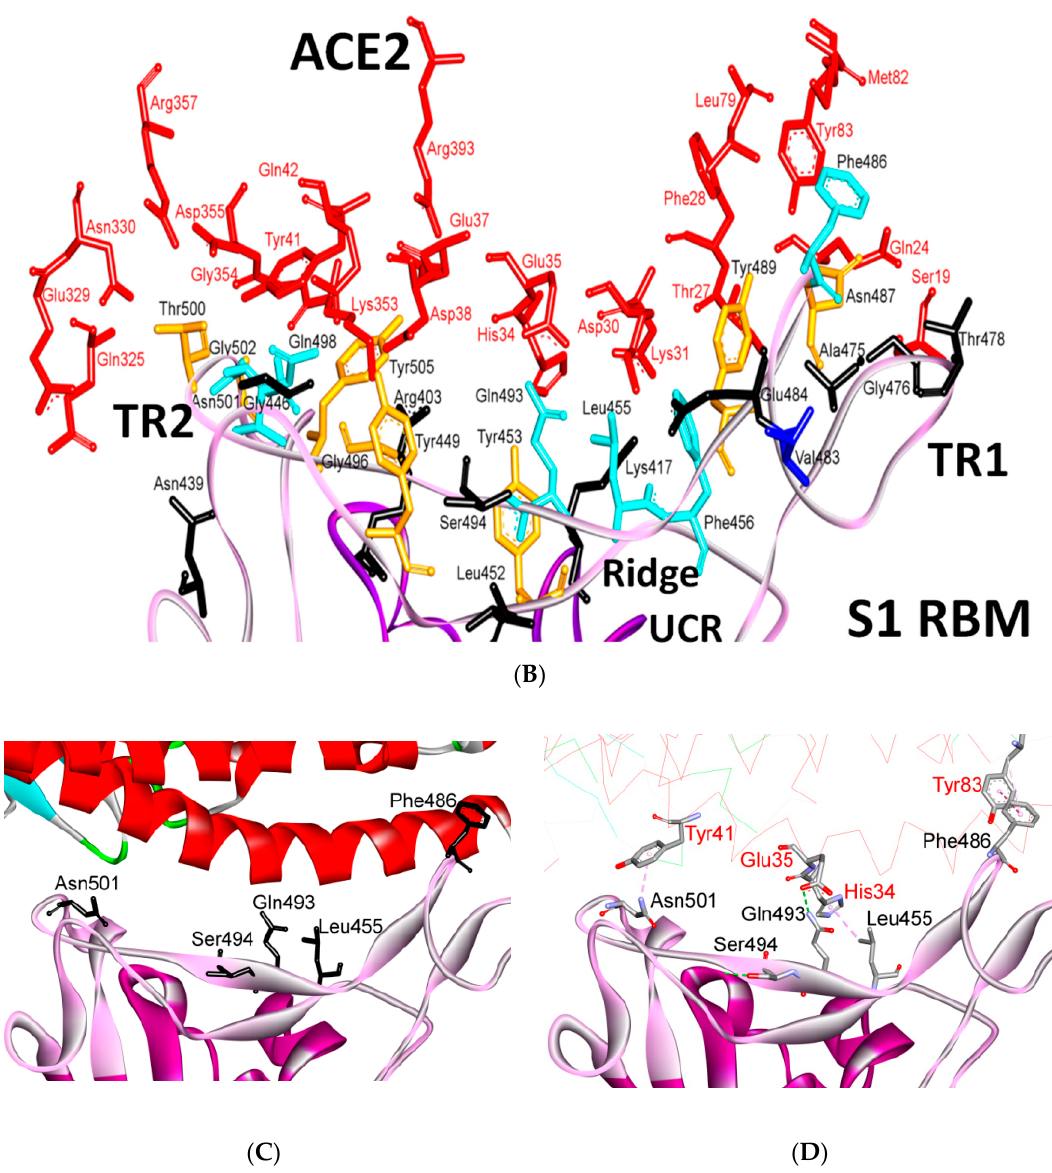
Figure 11. Binding interface and interactions between RBM of SARS-CoV and SARS-CoV-2 with ACE2. ( A , B ) interacting residues between the RBM and ACE2 for SARS-CoV and SARS-CoV-2, respectively. Red, orange, cyan and black colors indicate the interacting amino acids from ACE2, identical residues between SARS-CoV and SARS-CoV-2, di ff erent residues with partially conserved contacts, and di ff erent residues with di ff erent contacts, respectively. Ridge: region between TR1 and TR2. UCR: Upper core region. A Leu to Phe486 mutation (in addition to Pro to Ala475, Pro to Glu484, Lys to Thr478, Asp to Gly476 mutations and a Val483 insertion) in TR1 increases its hydrophobicity and the order of its structure, while mutations in the ridge region of Val to Lys417 (which makes electrostatic interactions), Asn to Gln493 (more hydrogen bonding), Asp to Ser494 and Lys to Leu452 (which increase the hydrophobicity of the shallow pit) give SARS-CoV-2 an advantage to bind mainly through these regions. Arg426, Thr433 and Tyr484 in SARS-CoV (instead of Asn439, Gly446 and Gln498 in SARS-CoV-2) produce more electrostatic, hydrogen bonding and stacking interactions, respectively, which give SARS-CoVan advantage to bind mainly through TR2. The use of di ff erent regions for binding may explain the di ff erences in a ffi nity and pathogenesis between SARS-CoV and SARS-CoV-2. ( C ) shows the five critical binding residues that are shown in Table 2. ( D ) shows the interacting residues from ACE2 with these critical residues. Three-dimensional models were created using Discovery Studio (version 2.5.5, Biovia, San Diego, CA, USA).